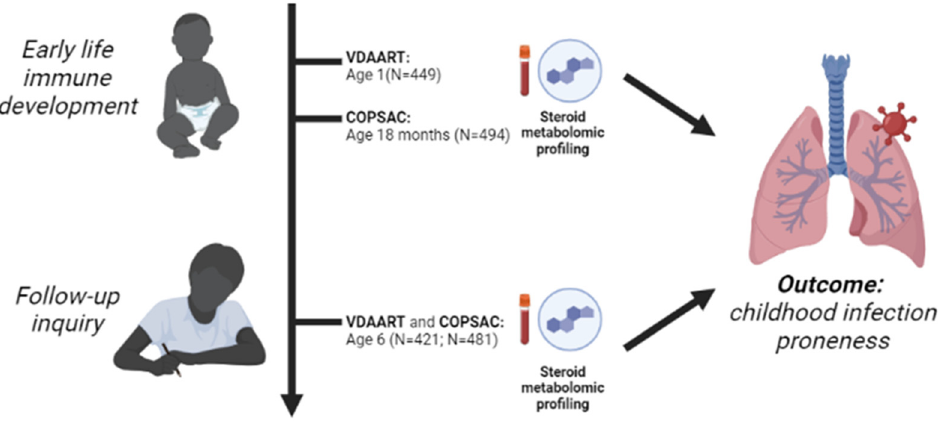
Figure 1. Overview of study design and analysis. A discovery and replication approach was utilized in which VDAART study participants served as the discovery cohort and COPSAC subjects served as the replication cohort. Plasma metabolomics were measured in infancy (age 1 year, age 18 months) with a further inquiry and follow-up at age 6 years to understand the associations between plasma steroid metabolites and childhood infection proneness. Image created using BioRender. Table 1. Demographic and clinical characteristics of child study participants in the VDAART dis- covery population and COPSAC replication population. Discovery Cohort: VDAART